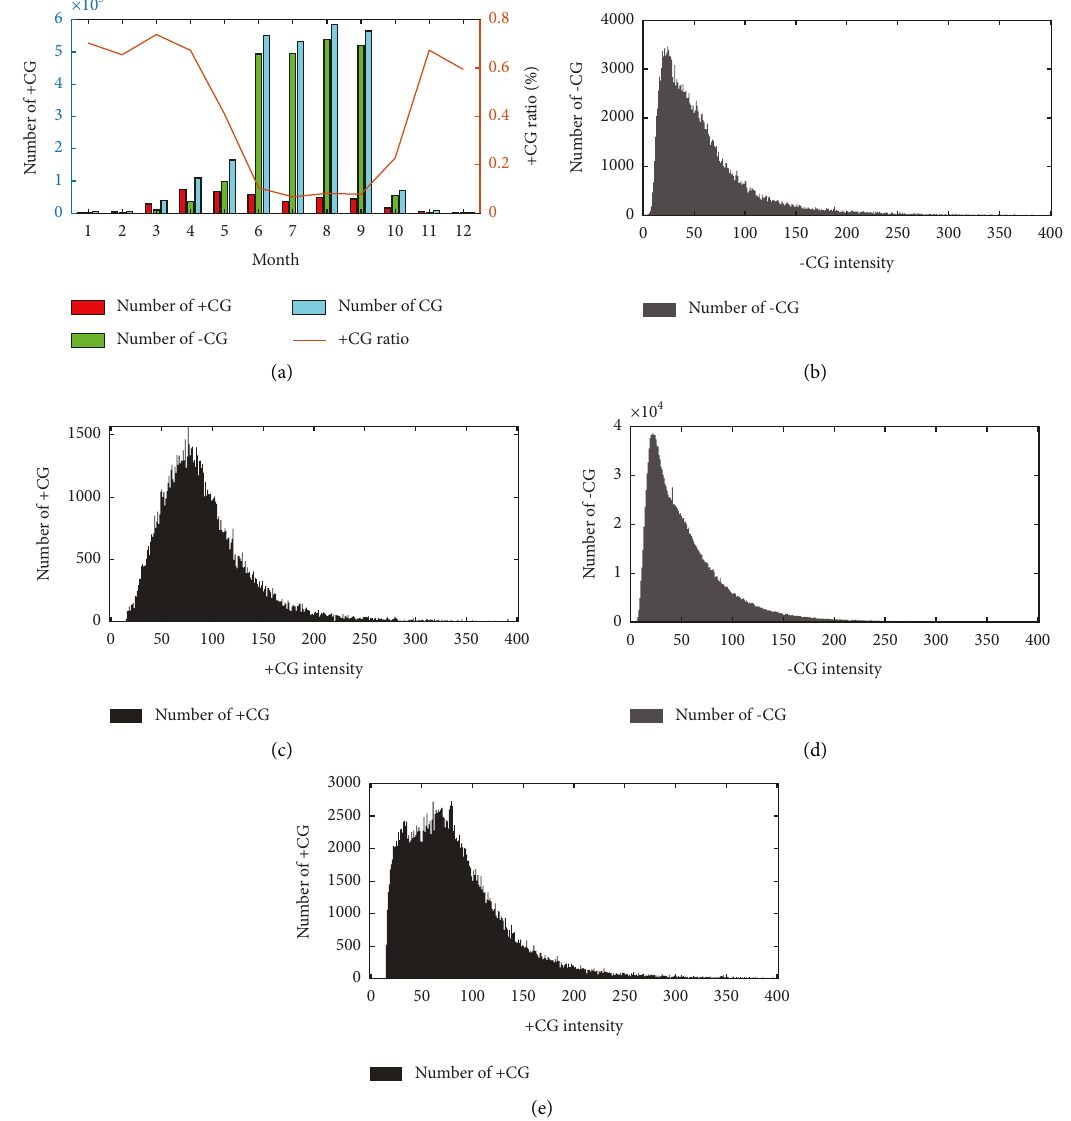
Figure 4: (a) Total number of +CG, − CG, and total CG lightning flashes in each month within 10 years, in which the broken line represents the proportion of +CG lightning in each month. (b, c) Probability distribution of − CG and +CG lightning intensity from June to September, respectively. (d, e) Probability distribution of − CG and +CG lightning intensity in other